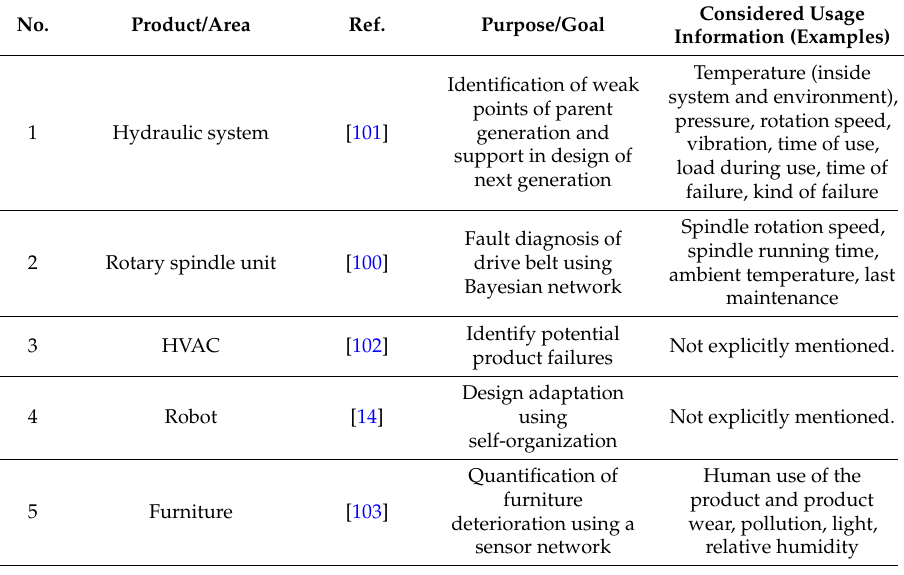
Table 3. Examples of products collecting usage information to support design